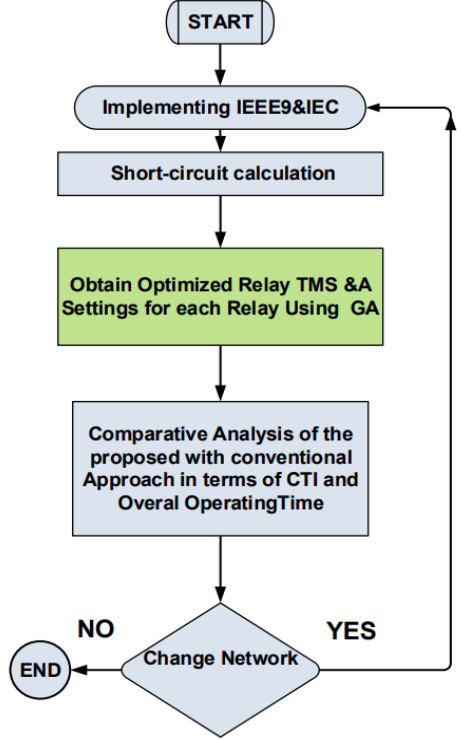
Figure 7. Flowchart of the Implementation of the NSTCC in Radial Networks.